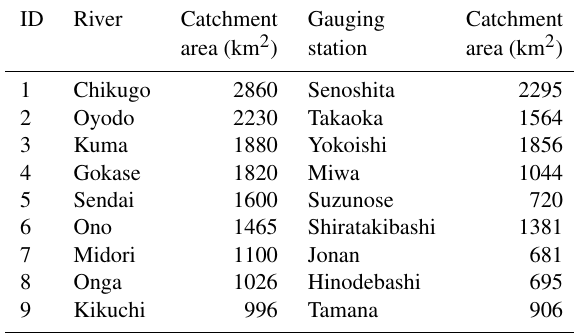
Table 1. Major rivers of Kyushu island. The gauging stations are the official reference points of rivers, where a long-term streamflow record is obtained for the planning of water management and de- velopment, with two exceptions. The official reference point for the Chikugo River is Arase (1443km 2 ) but, for wider coverage of the catchment, we used the downstream station of Senoshita. Similarly, the Sendai River is recorded at Sendai (1425km 2 ), but because that site is affected by the operation of the Tsuruda Dam, we used the upstream station of Suzunose.